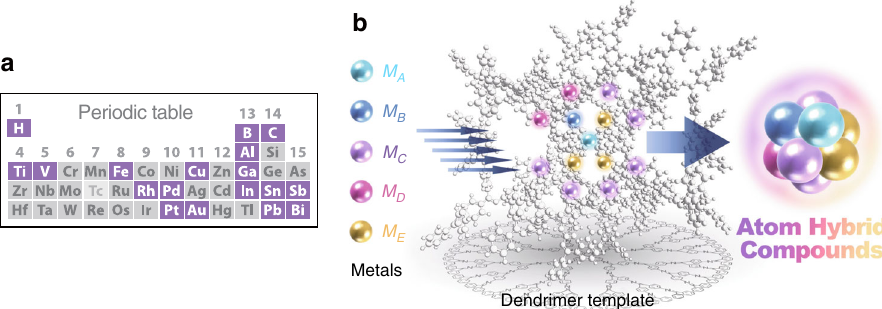
Fig. 1 Template synthesis of multimetallic sub-nanoclusters. a Metal elements precisely accumulated on the the phenylazomethine (DPA) dendrimer (purple-colored) and b concept of the “ atom hybridization ”